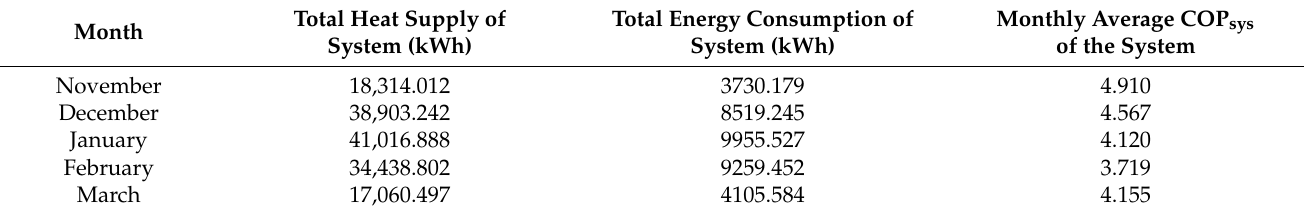
Table 5. Monthly average COP sys of the system.